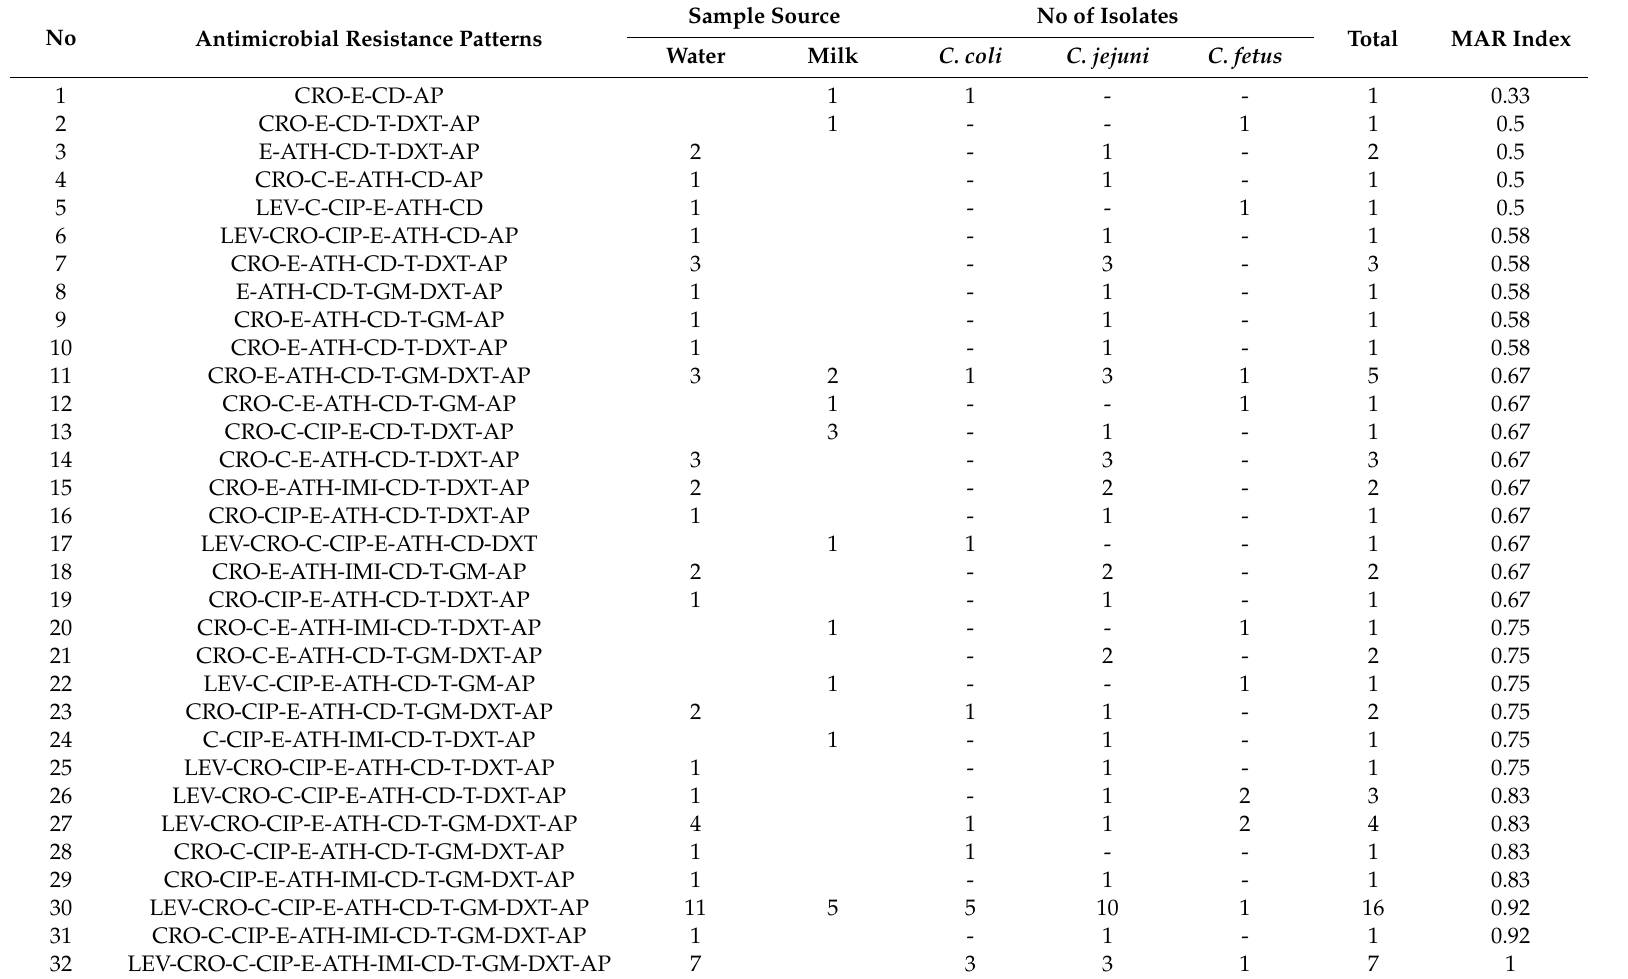
Table 3. Antibiotics phenotypic resistance patterns of Campylobacter